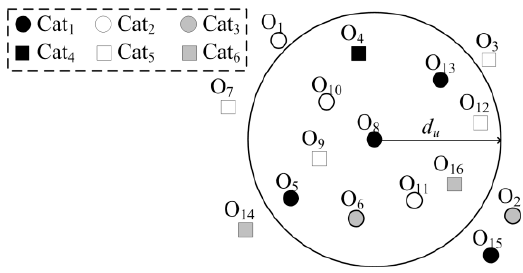
Figure 1. Example of proposed problem.